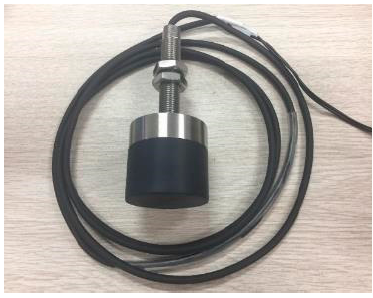
Figure 11. The developed eddy current sensor.